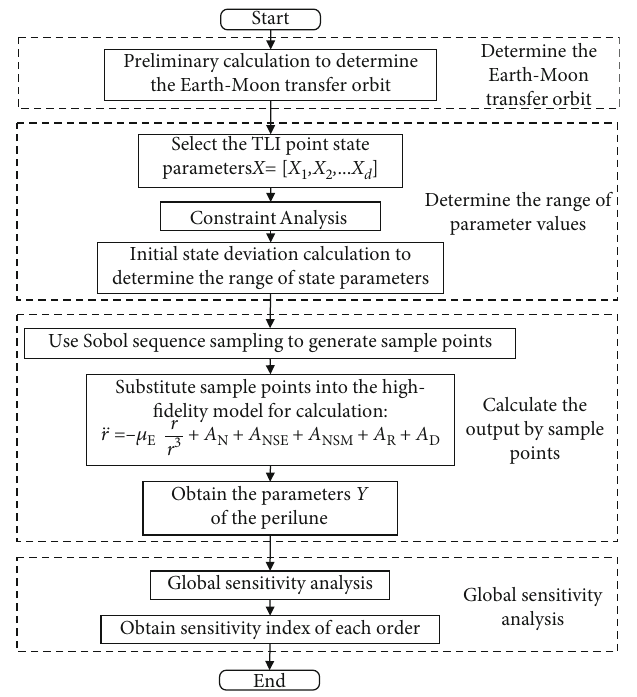
Figure 2: Global sensitivity analysis calculation process for Earth-Moon transfer